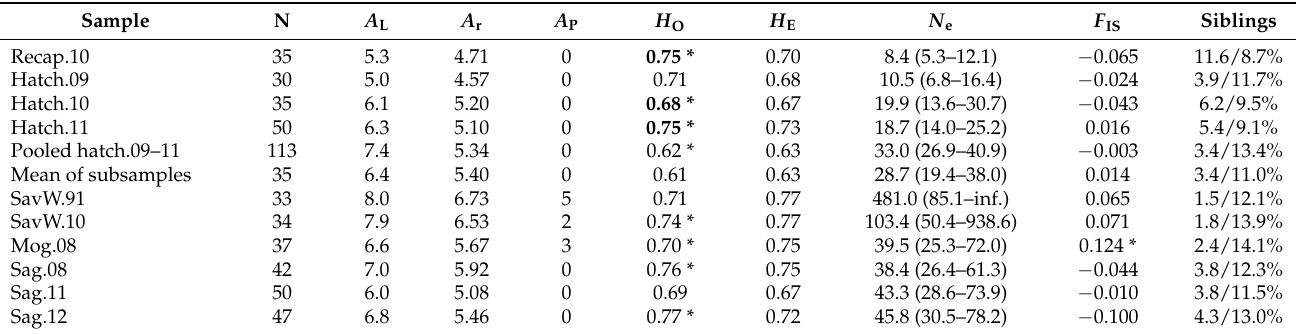
Table 1. Genetic diversity expressed as mean number of alleles pr. locus ( A L ), allele richness ( A r ), private alleles ( A P ) , observed ( H O ) and expected heterozygosity ( H E ), estimated effective population size ( N e ), inbreeding index ( F IS ), and number of full-siblings/half-siblings in percent of possible pairs (n × (n − 1)/2) (N = sample size). * = significant deviation from HW—equilibrium, boldface = significant after Bonferroni correction.